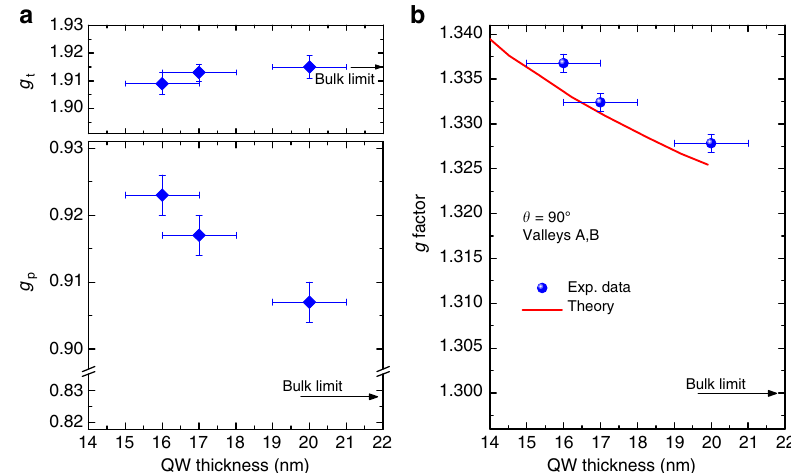
Figure 3 | Confinement-induced g factor tuning. ( a ) Values of g p and g t parameters reported in ref. 47 for bulk Ge (arrows), and obtained in this work (diamonds) for Ge QWs with different thickness. Errors bars were derived from the least square fitting analysis of the experimental data. ( b ) g factor values at y ¼ 90 (cid:2) for the valleys A and B as a function of the QW thickness. The experimental data for Ge QWs (dots) are reported along with the values calculated by Baron et al. in ref. 42 (red line), and the reference values of bulk Ge according to ref. 47. Error bars of the g factor were derived from the resonance field uncertainty.